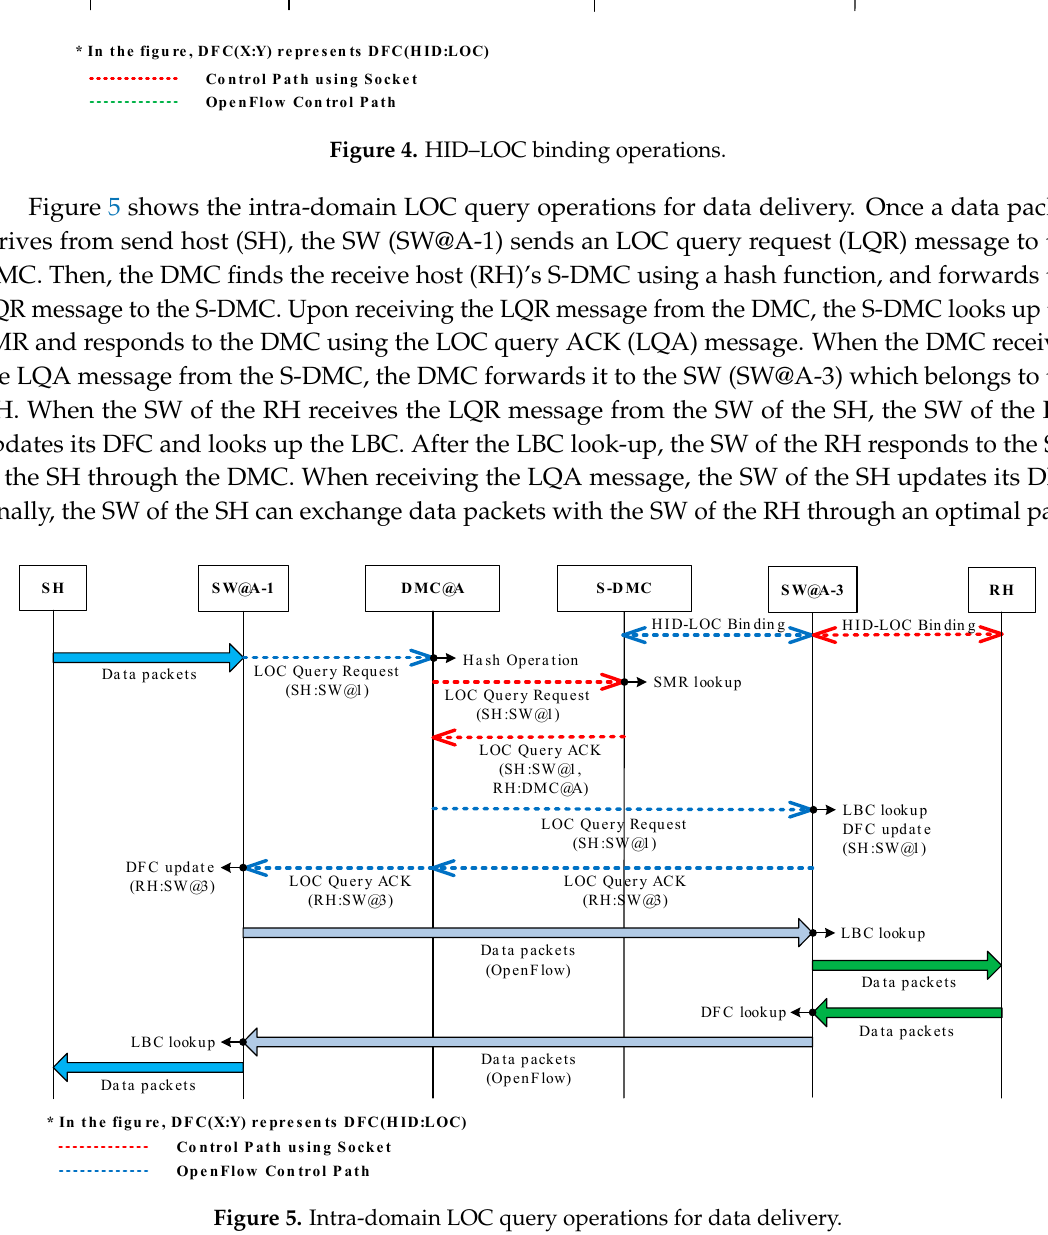
Figure 5. Intra-domain LOC query operations for data Figure 5. Intra ‐ domain LOC query operations for data delivery.